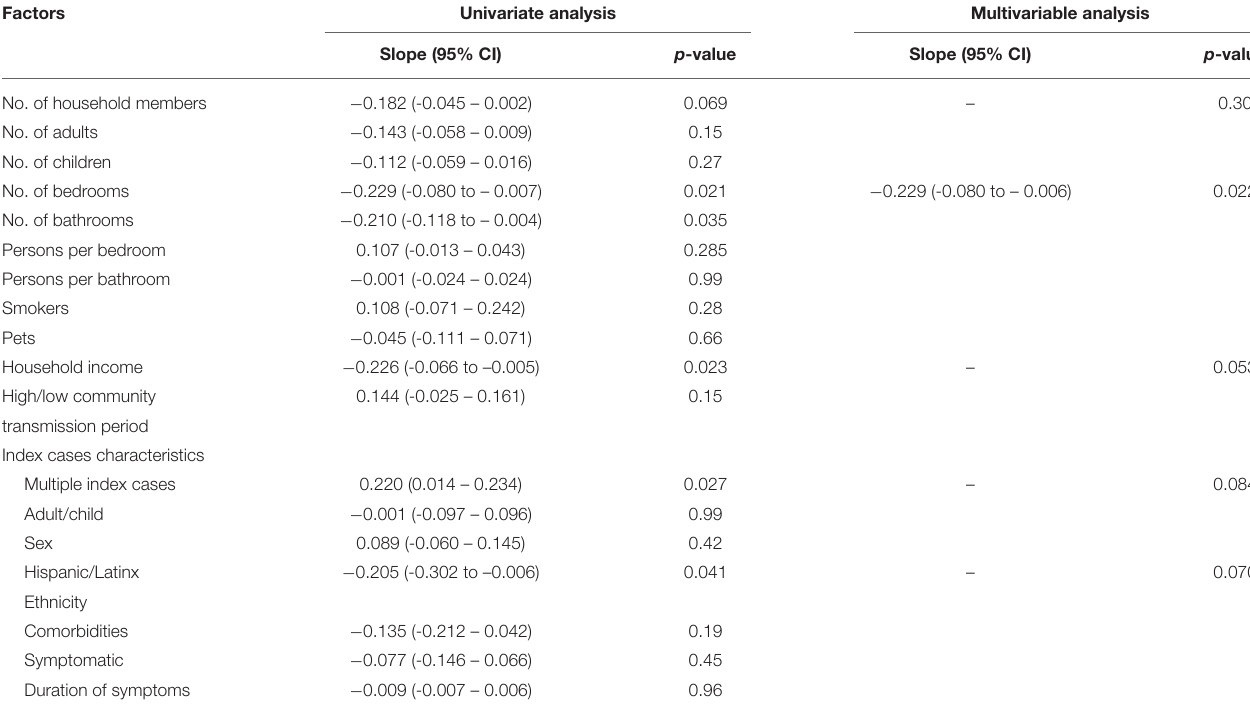
TABLE 4 | Univariate and multivariable linear regression analysis of predictors of the household attack rate (includes index cases).